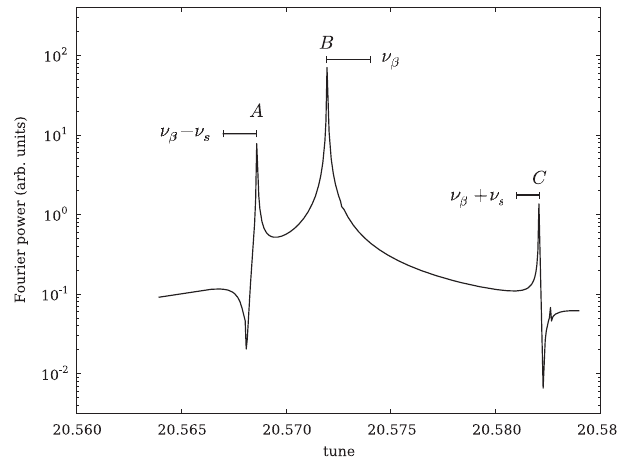
FIG. 3. Simulated spectrum of a two slice bunch in the pres- ence of wakefields and synchrotron motion showing three syn- chrobetatron modes A , B , and C induced by